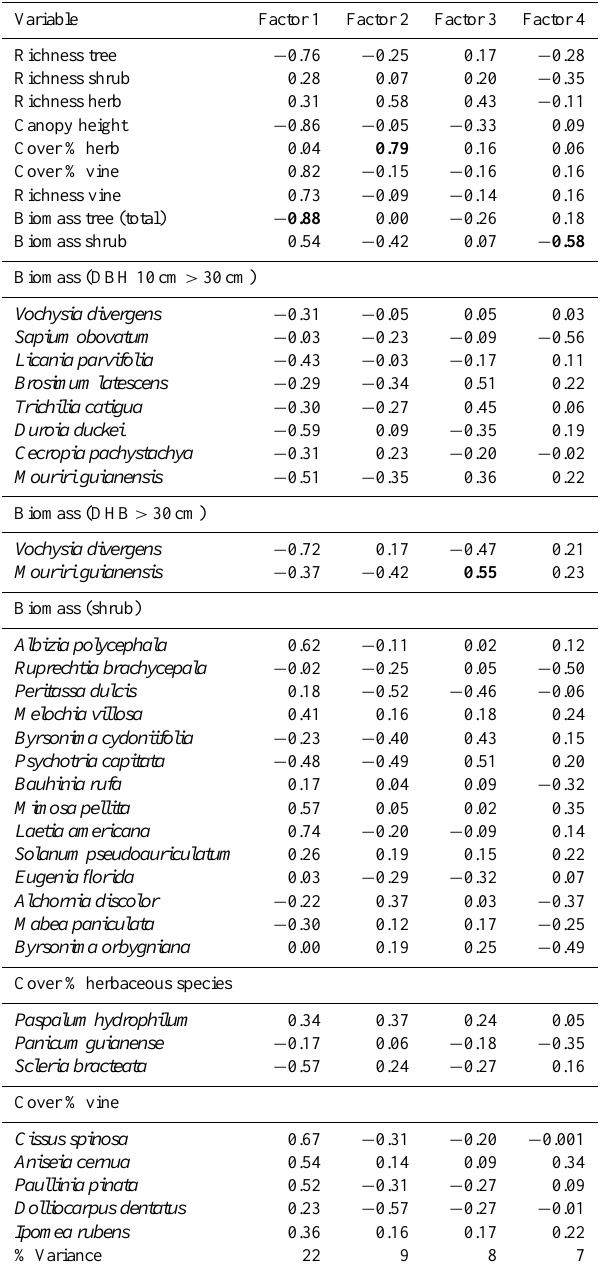
Table 2. Summary statistics for the factor analysis. Numbers in bold highlight the highest correlation with the factor